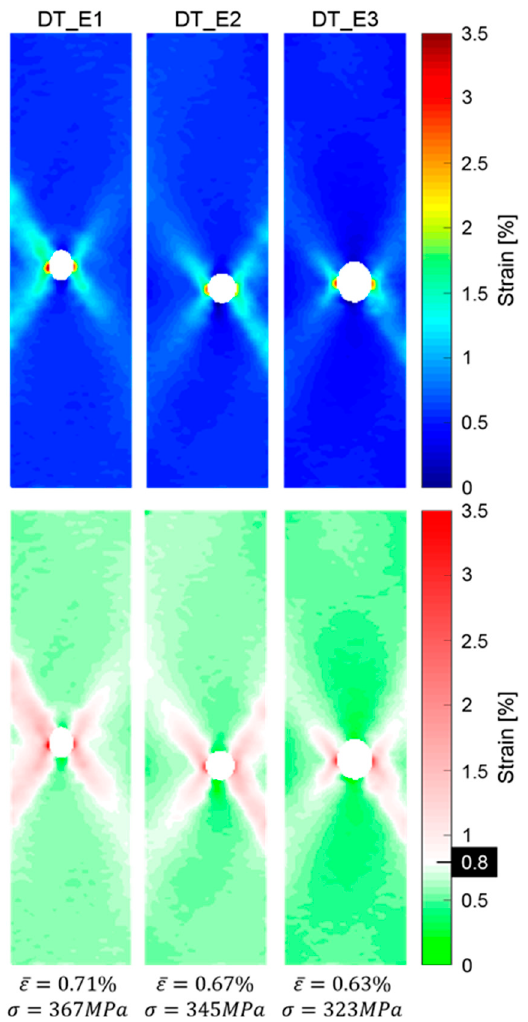
Figure 16. Post-impact tensile tests: full tensile strain field and threshold strain. Samples impacted at 2.2 J (DT_E1), 3.2 J (DT_E2) and 4.2 J (DT_E3).